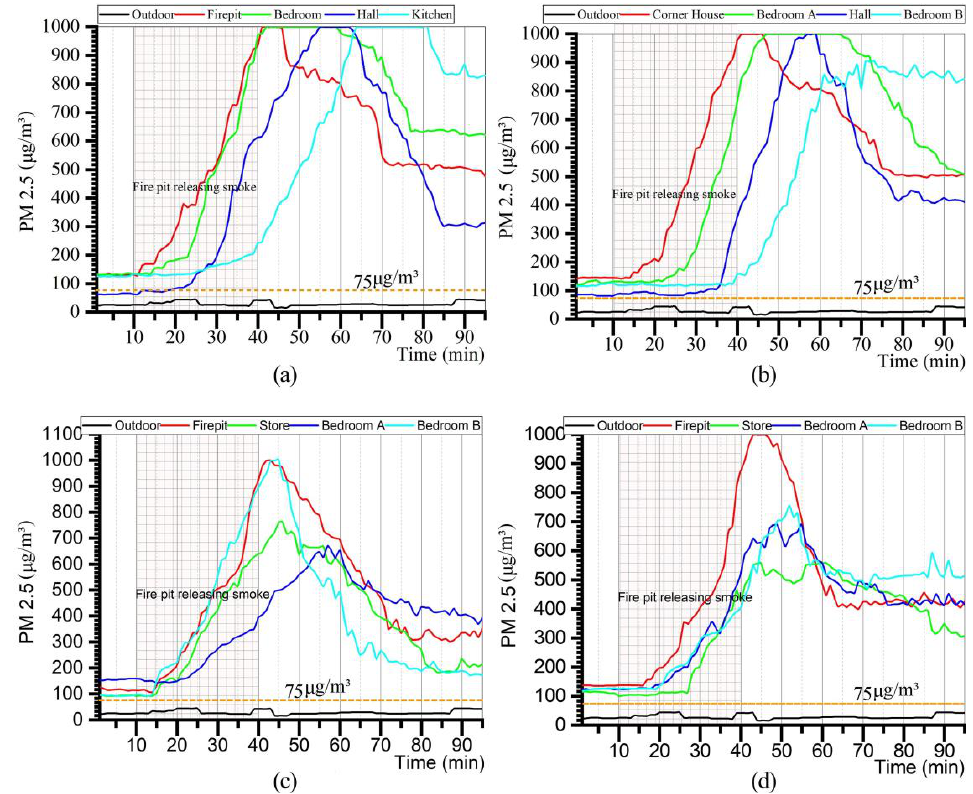
Figure A2. Indoor PM 2.5 concentration monitoring results. ( a ) Zuozi dwelling [34], ( b ) L-shape dwelling [34], ( c ) lower store and upper house dwelling, ( d ) front store and back house dwelling.